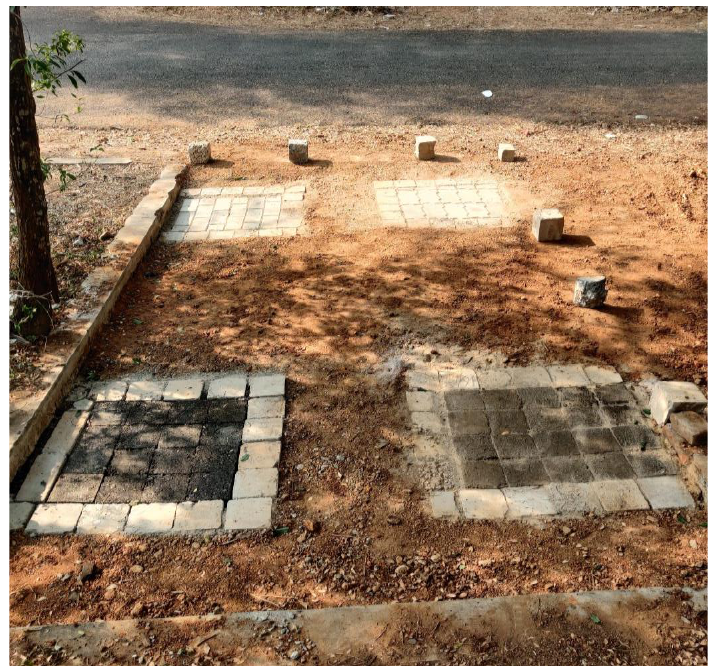
Figure 9. Pavement block construction (parking lot).